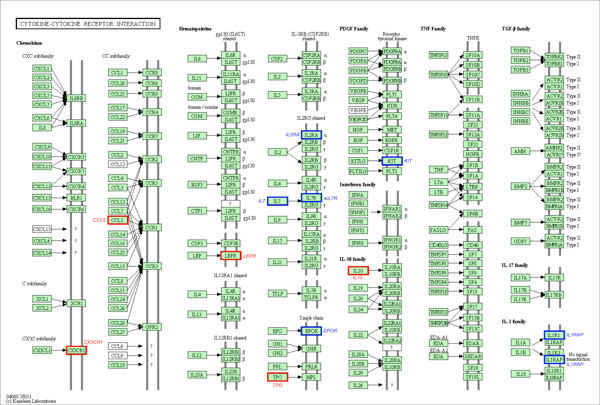
The iLOCi detected genes from CAD and their maps in 'cytokine-cytokine receptor interaction' pathway. The KEGG pathway diagram [34] shows the mapping of CAD-associated genes identified among 1000 top ranked iLOCi pairs in 'cytokine-cytokine receptor interaction' pathway. The gene families containing the genes previously reported in the HuGE Navigator database and novel disease genes are highlighted in the red boxes and the blue boxes, respectively, with their associated gene names.